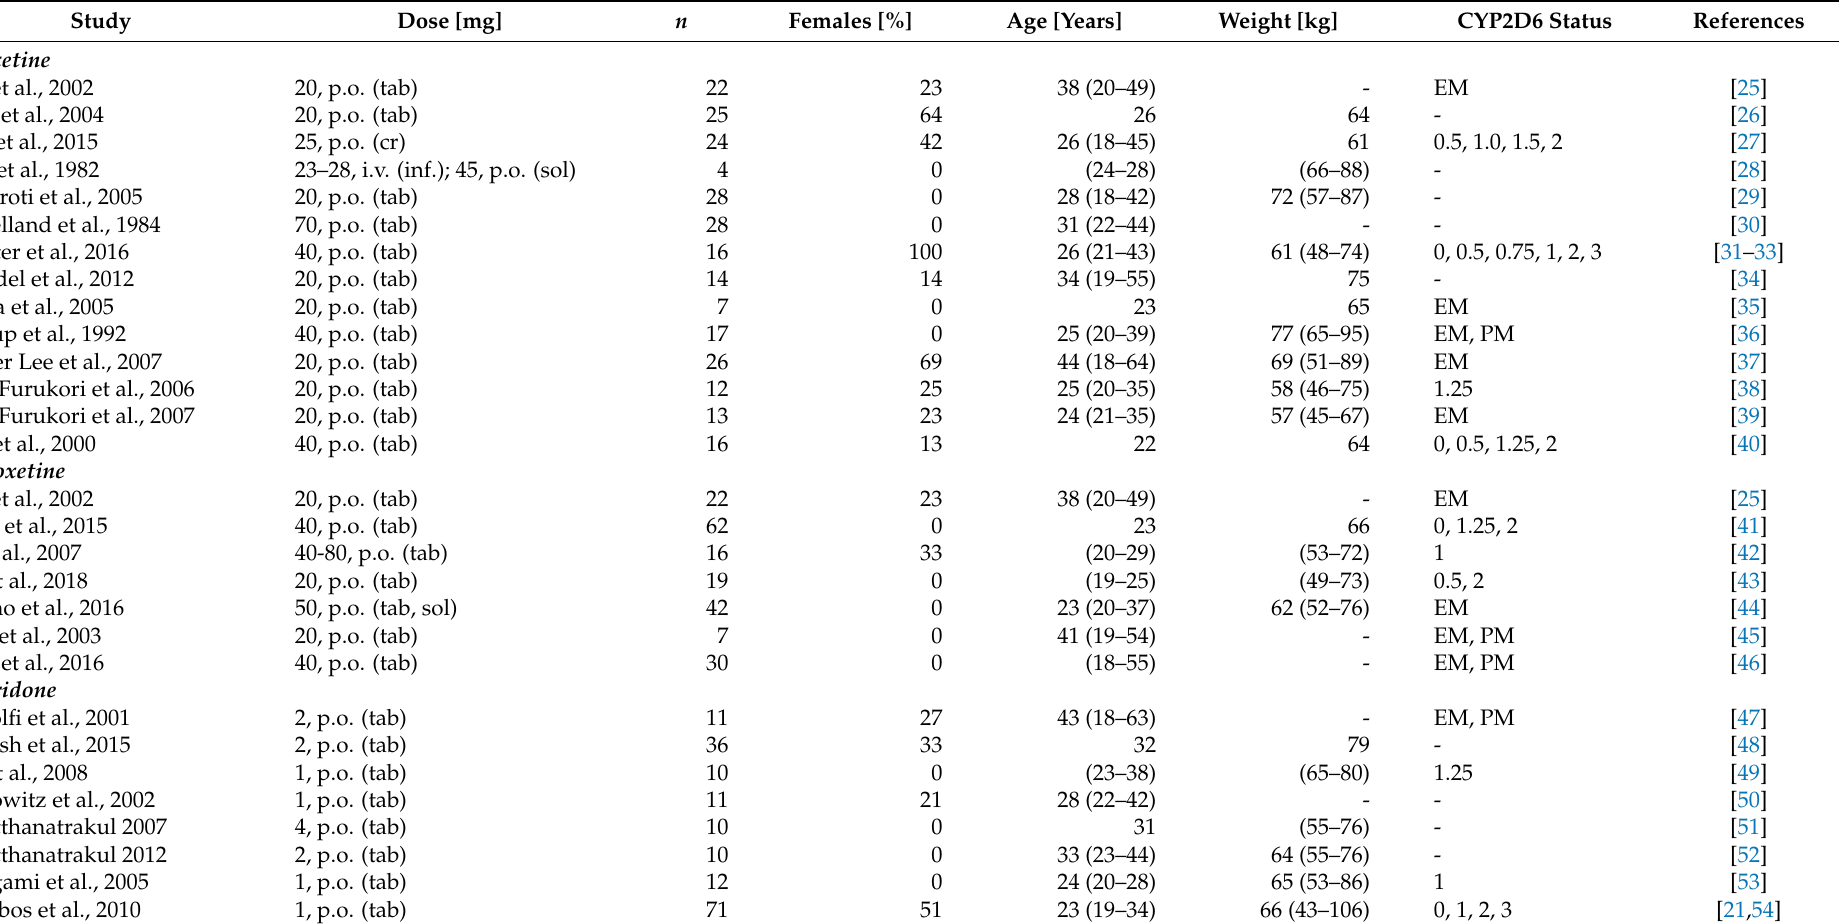
Table 1. Summary of clinical studies used for model development and